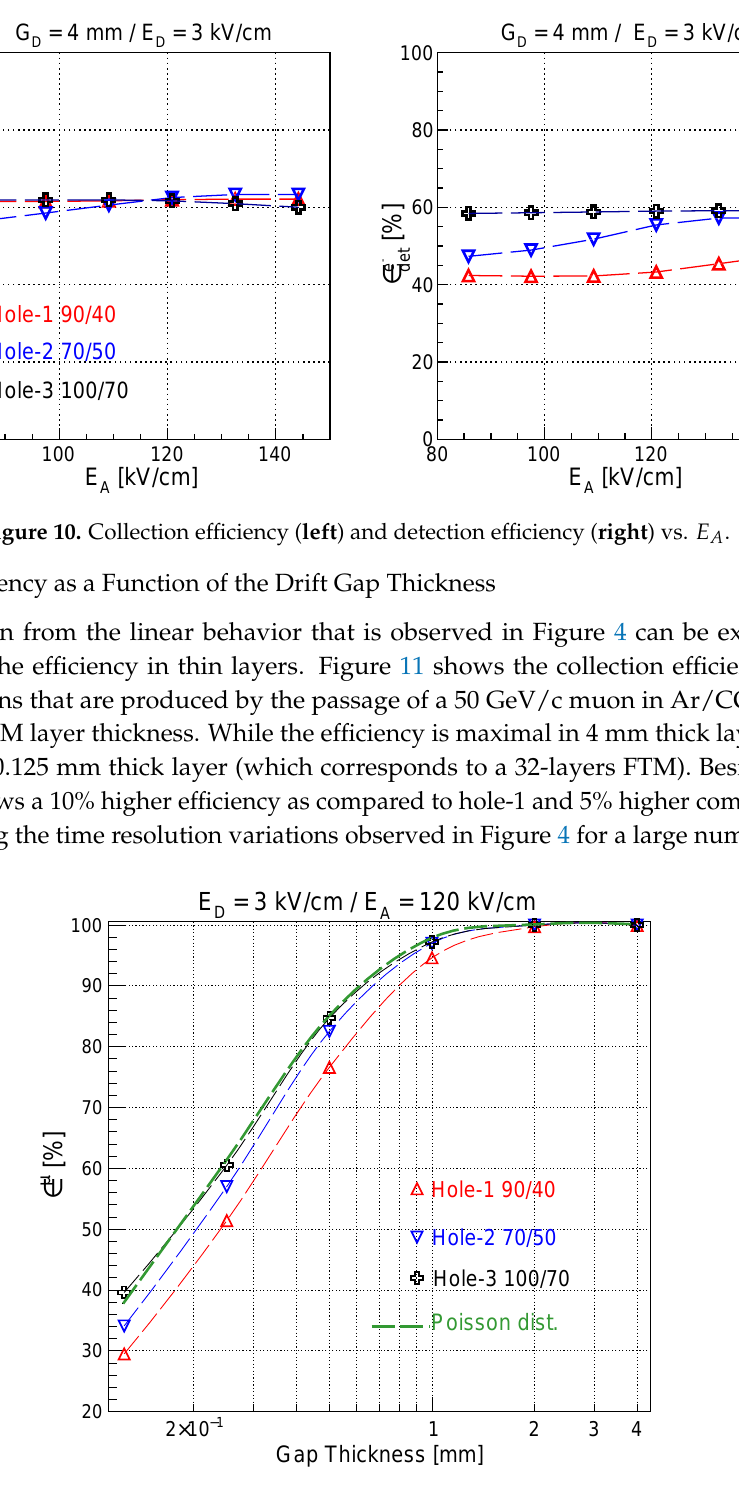
Figure 11. Global detector efficiency for muons vs. drift gap thickness, compared to the theoretical prediction from Poisson distribution, showing the deterioration of efficiency in thin layers. Hole-3 shows 10% higher efficiency as compared to hole-1